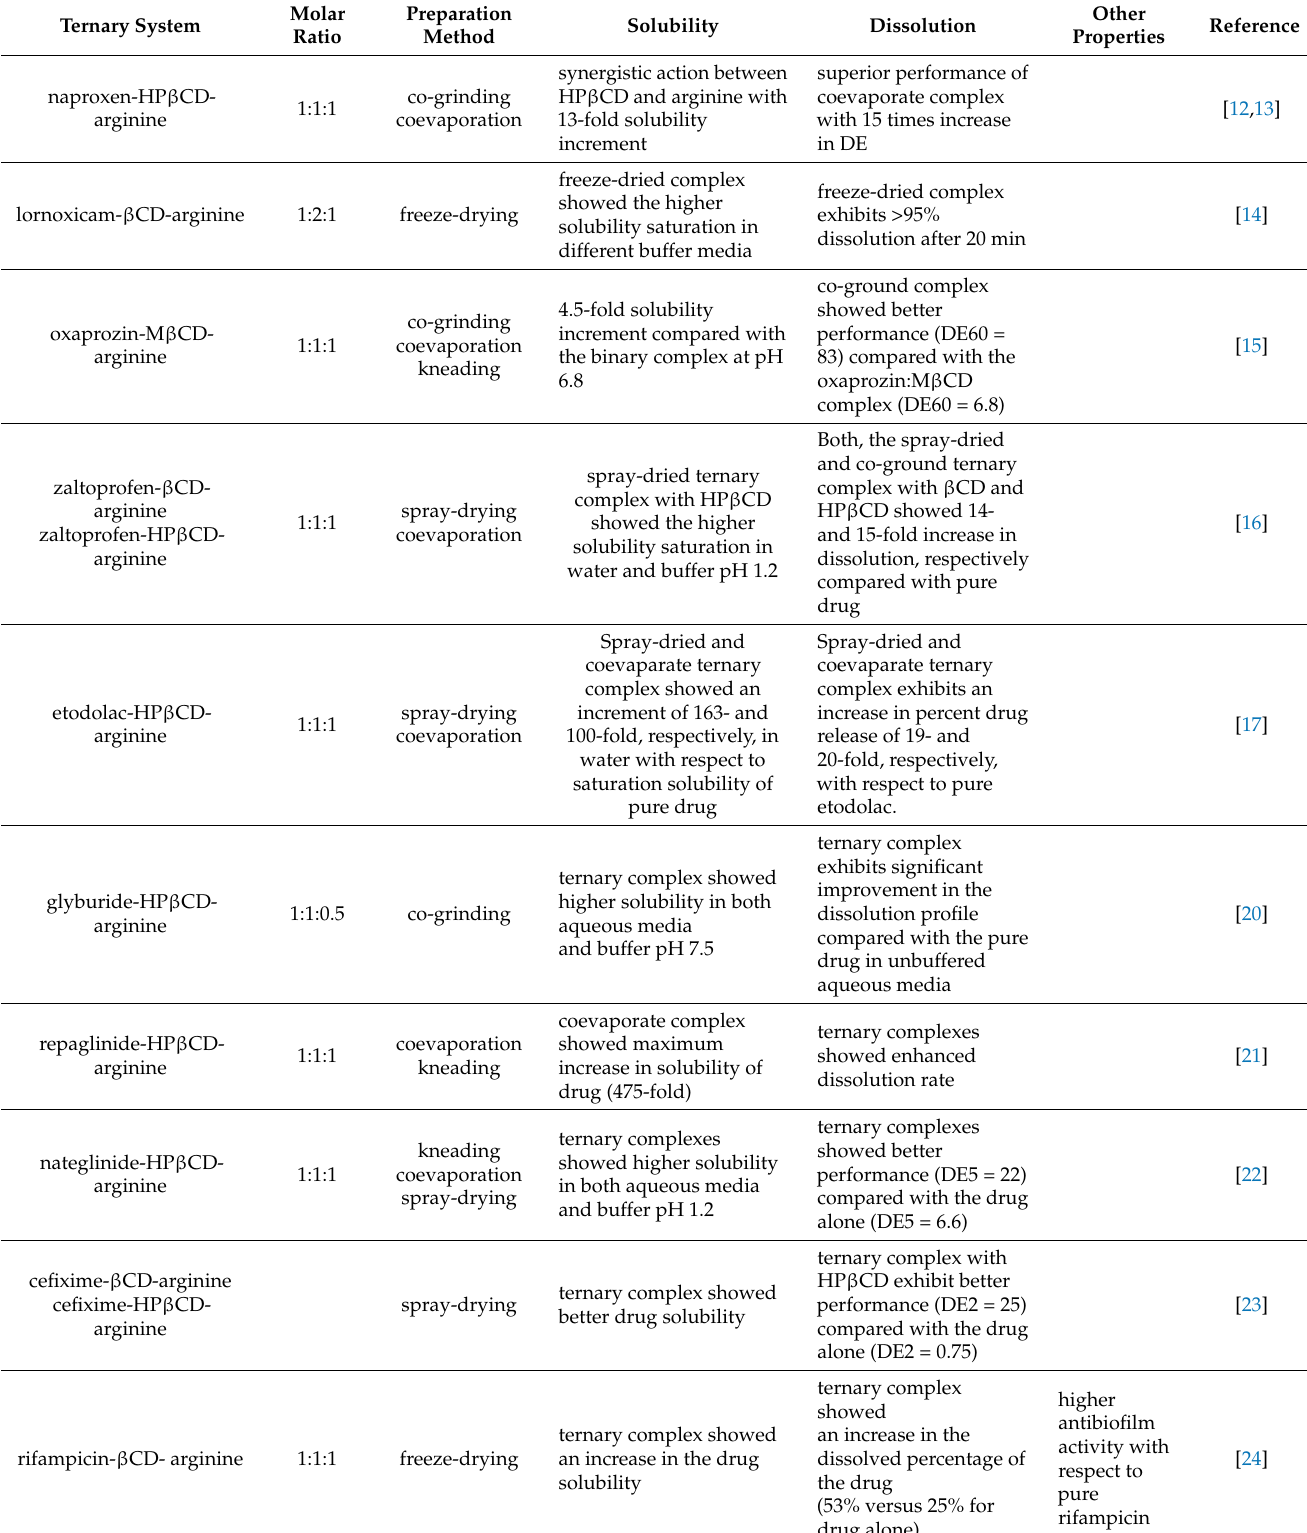
Table 1. Summary of some reports on ternary complexes of CDs with arginine, including the improvements in pharmaceuti- cal